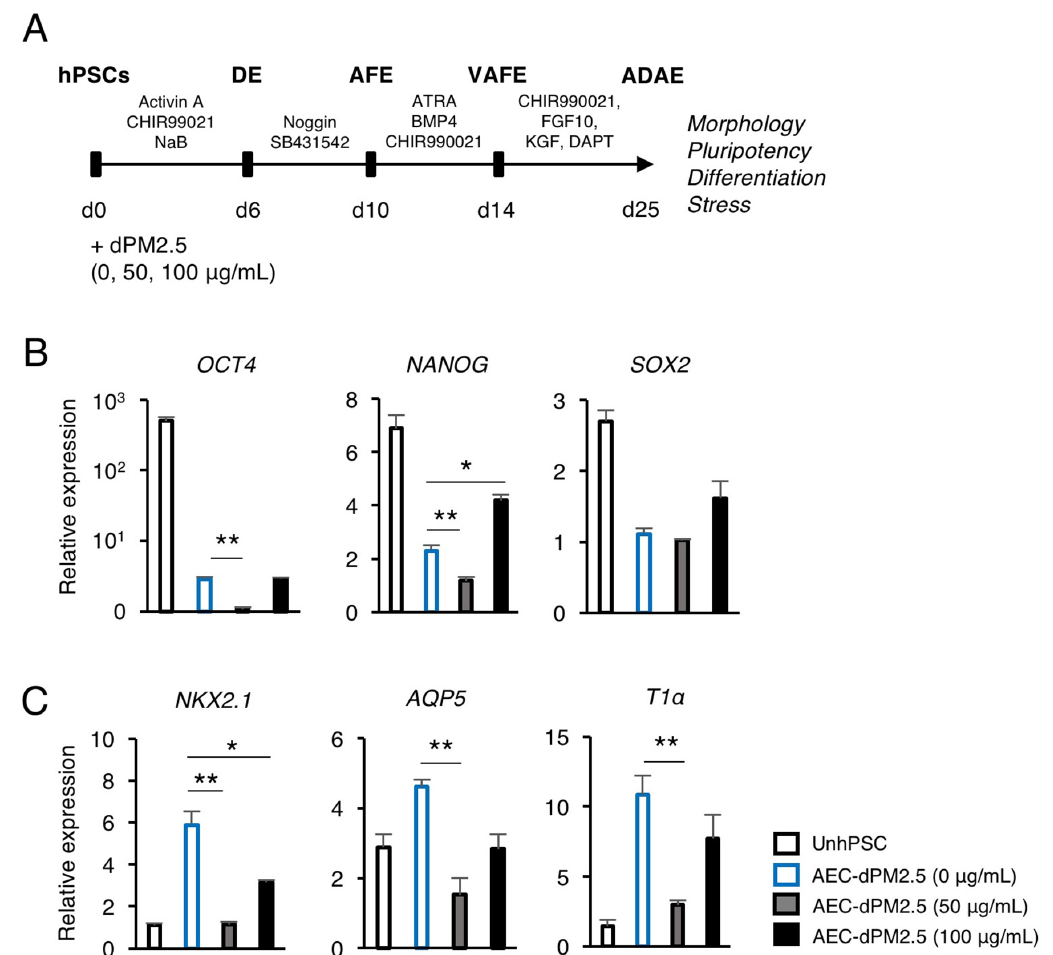
Figure 2. Effects of dPM2.5 exposure on hPSC-derived alveolar epithelial cell (AEC) differentiation. ( A ) Schematic diagram of stepwise AEC differentiation from hPSCs based on lung developmental process and dPM2.5 treatment. ( B , C ) qPCR analysis for the expression of pluripotency ( OCT4 , NANOG, and SOX2 ) and alveolar epithelium ( NKX2.1 , AQP5, and T1 α ) markers. Data is presented as mean ± SD. * p < 0.05, ** p < 0.01. UnhPSC, undifferentiated hPSC; DE, definitive endoderm; AFE, anterior foregut endoderm; VAFE, ventral anterior foregut endoderm; ADAE, alveolar and distal airway epithelium.